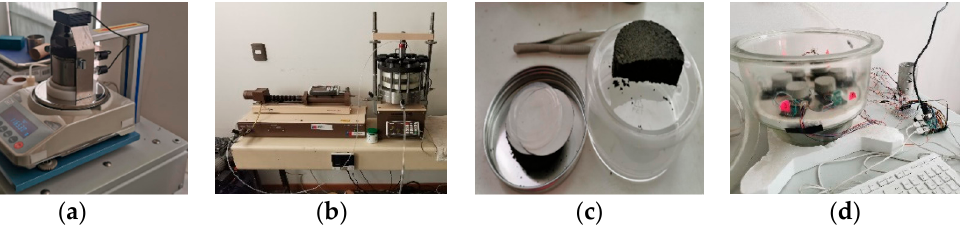
Figure 7. Equipment used to obtain the SWCC. ( a ) Ku-pf; ( b ) GDS oedometer; ( c ) filter paper; ( d ) equilibrium vapor. ( d ) equilibrium vapor.